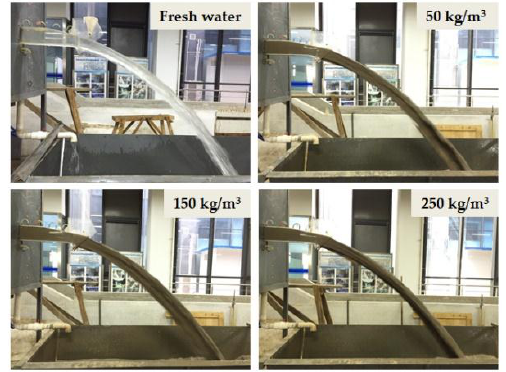
Figure 3. Nappe regimes at different sediments concentrations.